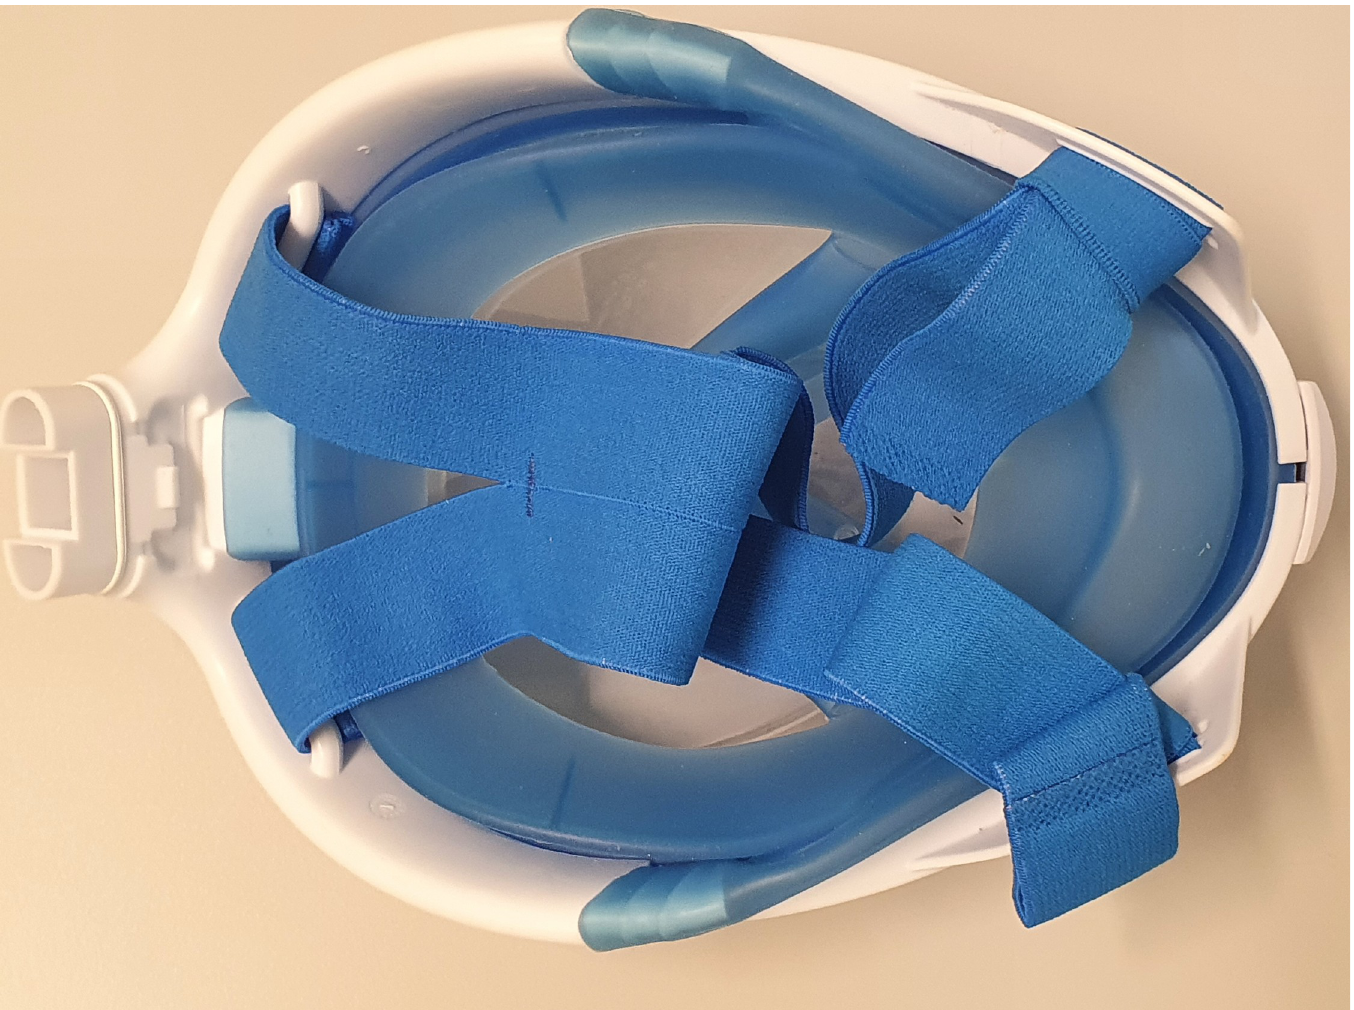
Fig 7. Face-side of commercial mask. The edge (blue rubber) of the commercial mask Easybreath 1 is thick and made of a different material than the mask. It therefore creates a tight sealing.